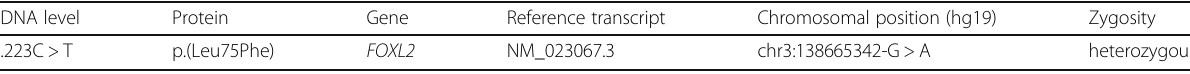
Table 3 FOXL2 variant in